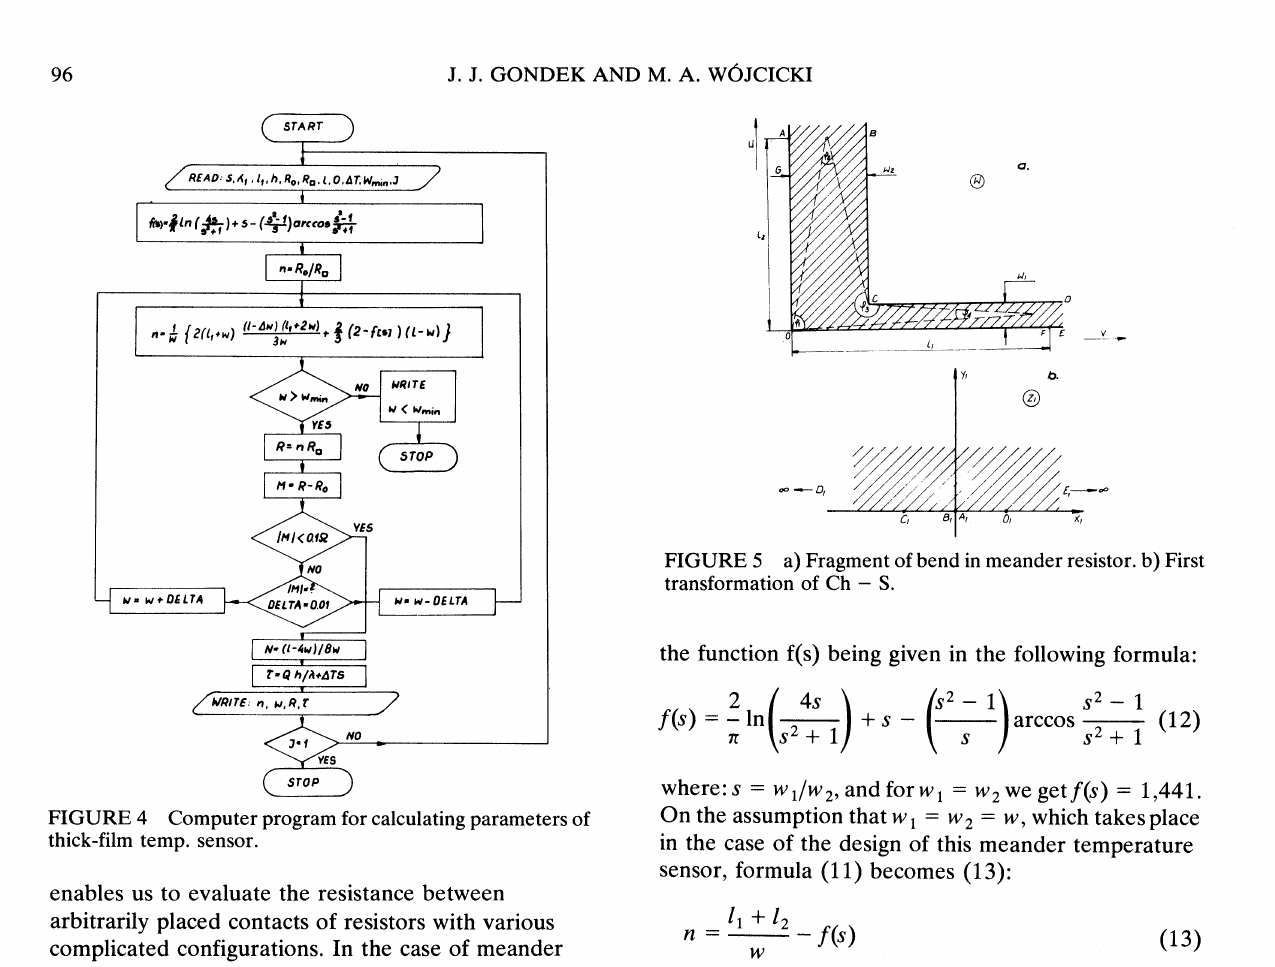
FIGURE 4 Computer program for calculating parameters of thick-film temp. sensor.